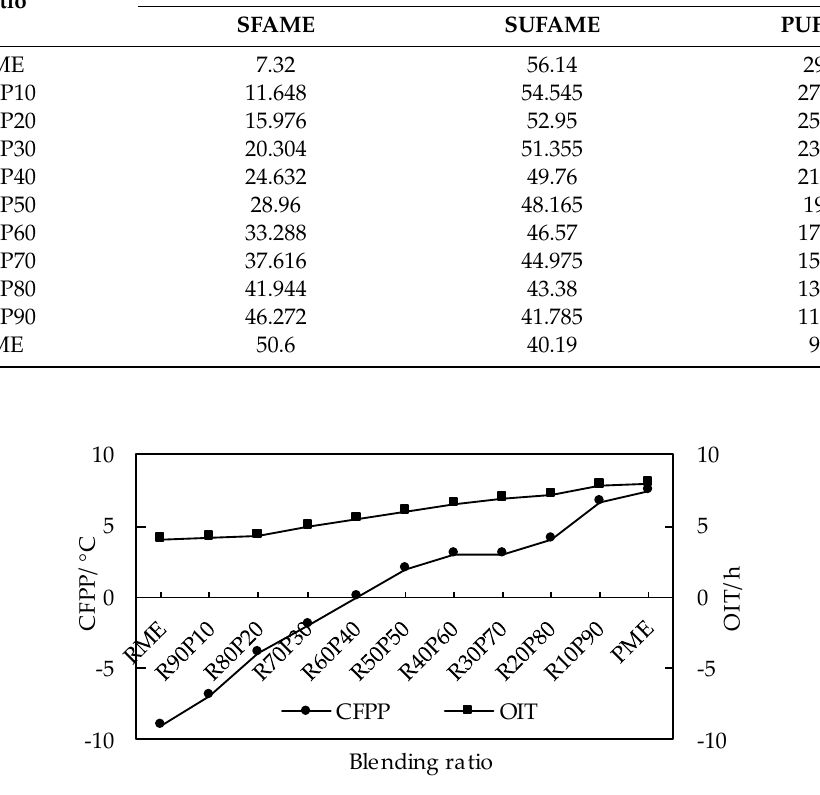
Figure 11. Effects of blending ratio on coupling relationship between low temperature fluidity and oxidation stability of biodiesel.